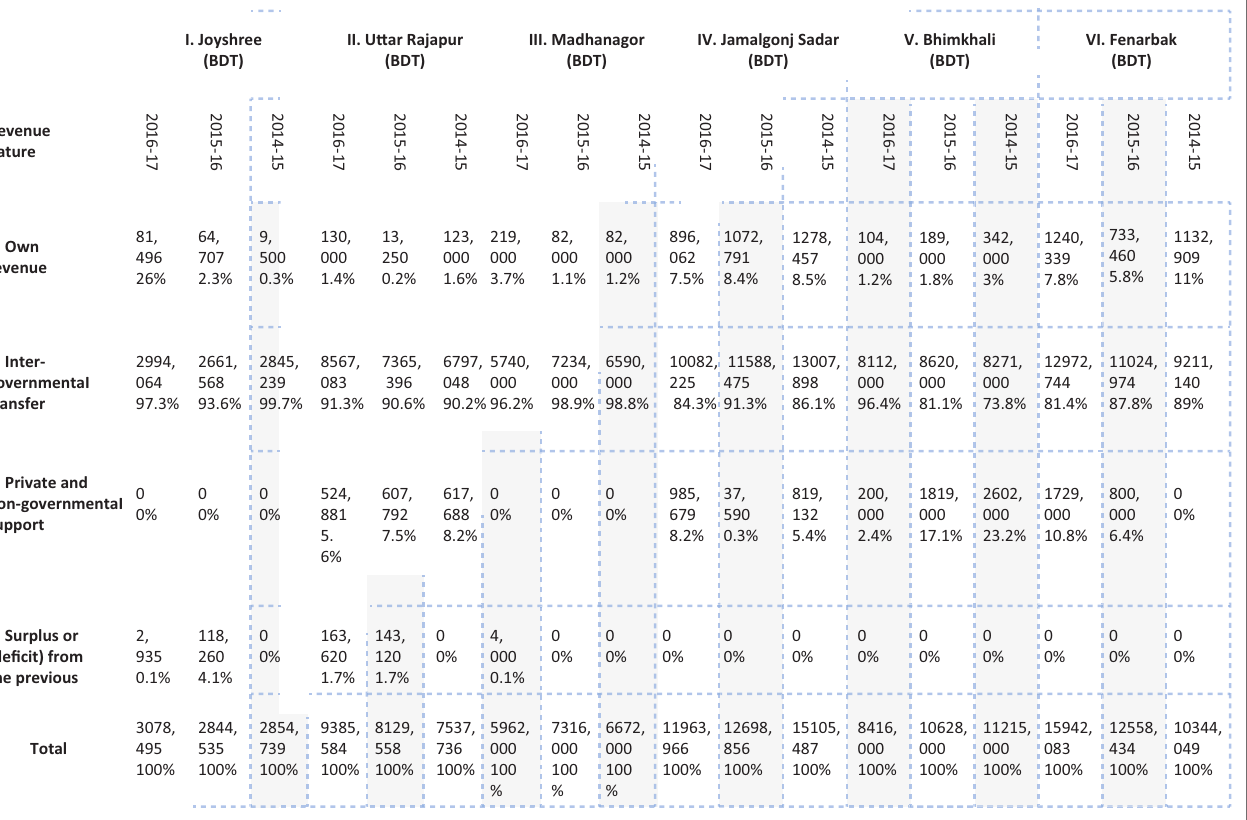
FIGURE 1-A3: Revenue statement of local government union